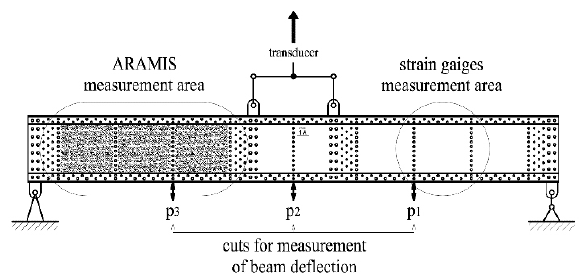
Fig. 3. Arrangement of the measuring equipment